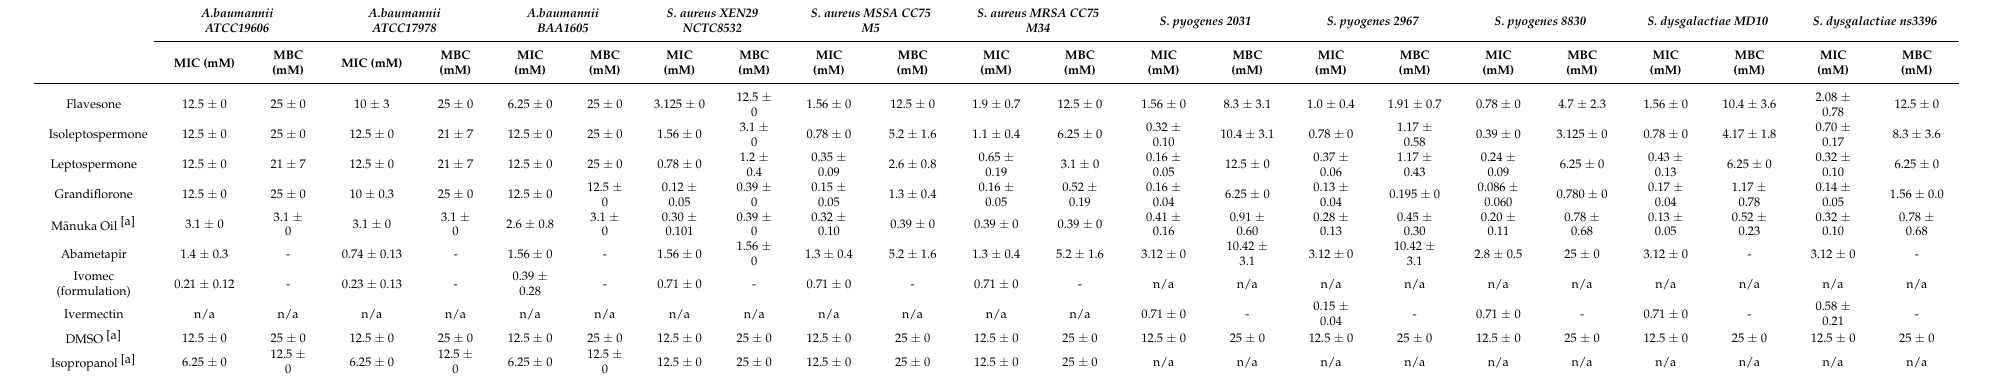
Table 2. MIC and MBC values for commercial m¯anuka oil, flavesone, leptospermone, isoleptospermone, grandiflorone, abametapir, ivermectin (topical formulation) and pure ivermectin against pathogenic bacterial strains, Acinetobacter baumannii , Staphylococcus aureus , Streptococcus pyogenes and Streptococcus dysgalactiae